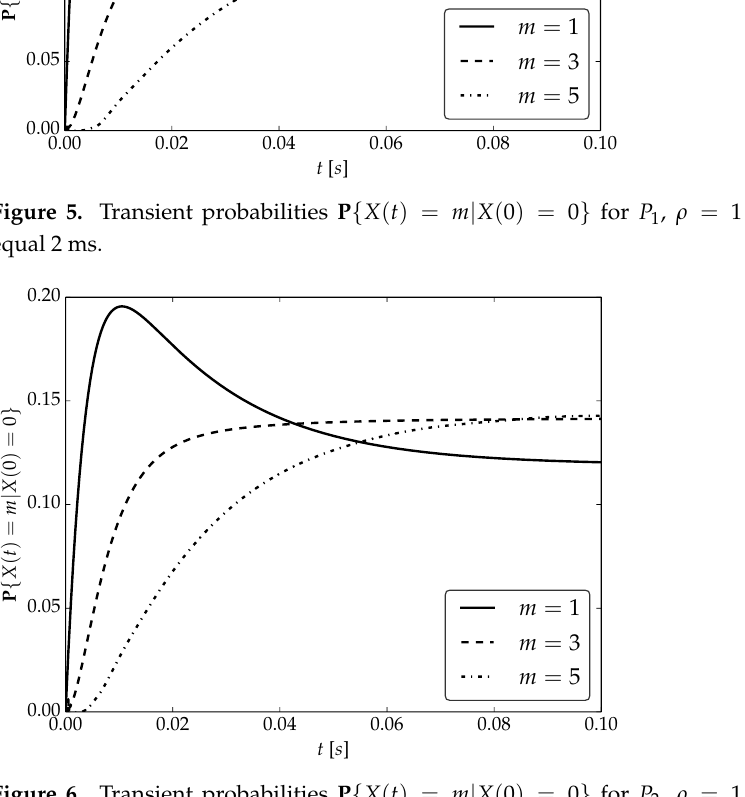
for P 2 , ρ = 1 and mean setup time X ( t ) = m X ( 0 ) = 0 { | }